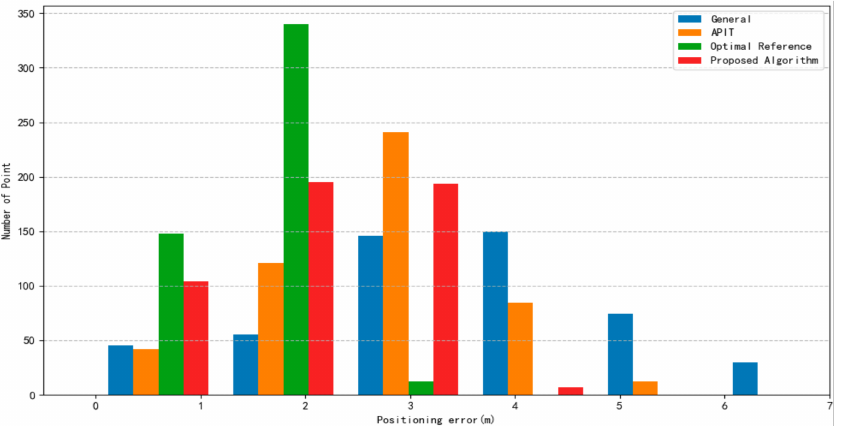
Figure 11. Histogram plot of the positioning